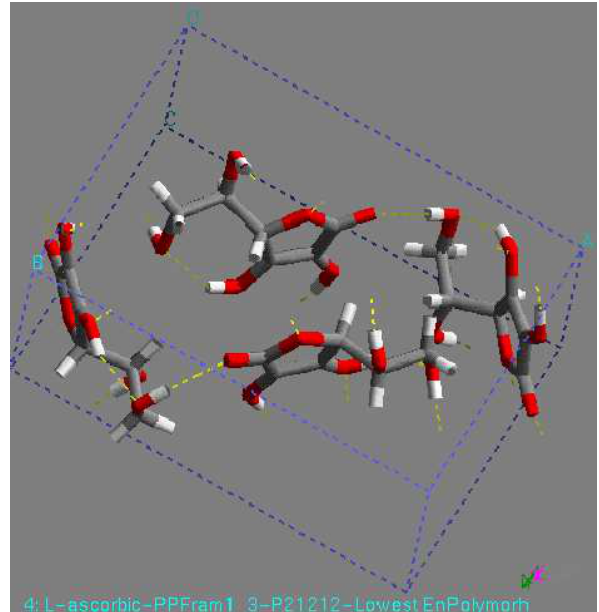
Figure 5. P21212 structure, found by minimization. This structure had the lowest lattice energy in the DREIDING force field. View along the